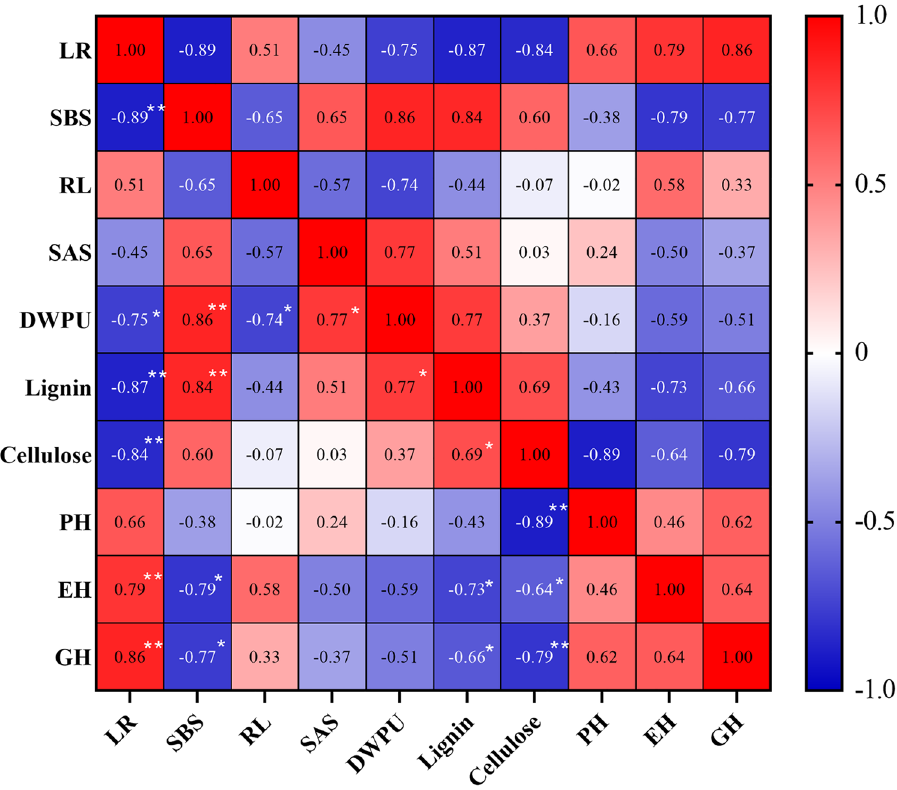
Figure 4. Correlation analysis between lodging rate and lodging-related characteristics. The red and blue colors present a positive and negative correlation, respectively; * and ** indicate differences significant at 0.05 and 0.01 levels, respectively.